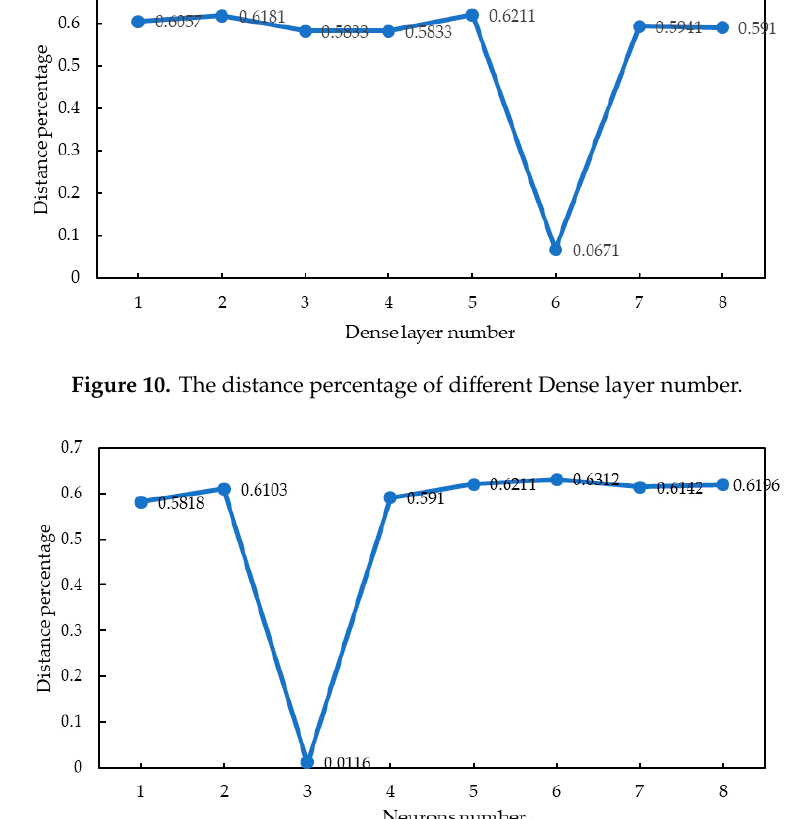
Figure 11. The distance percentage of different neurons number.